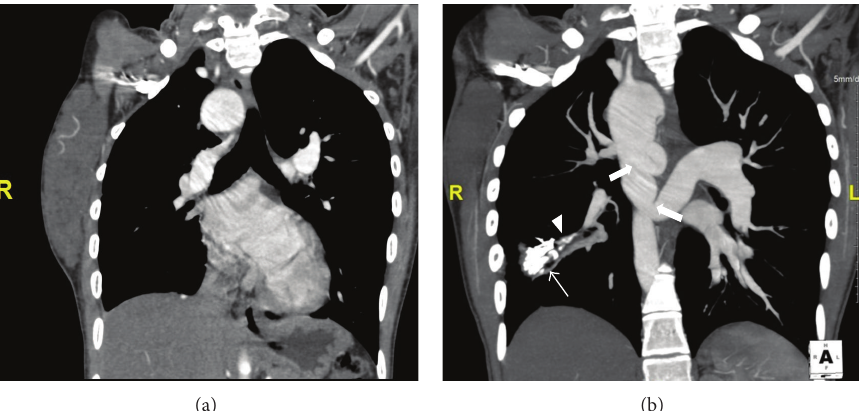
Figure 4: (a) and (b) Coronal CT pulmonary angiography: MIP (maximum intensity projection) images reveal a right sided aortic arch with large arterial channels arising from the left lateral aspect of the descending thoracic aorta (thick arrows) representing MAPCAs supplying the pulmonary parenchyma. Also seen is a calcified lesion (thin arrow) in the lower lobe of the right lung with a vascular pedicle (arrow head).